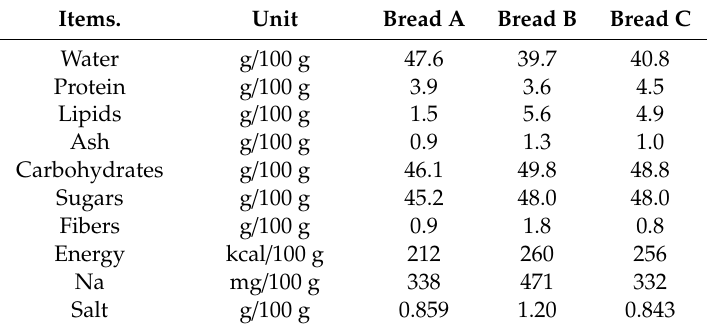
Table 1. Composition analyses of breads. Items. Unit Bread A Bread